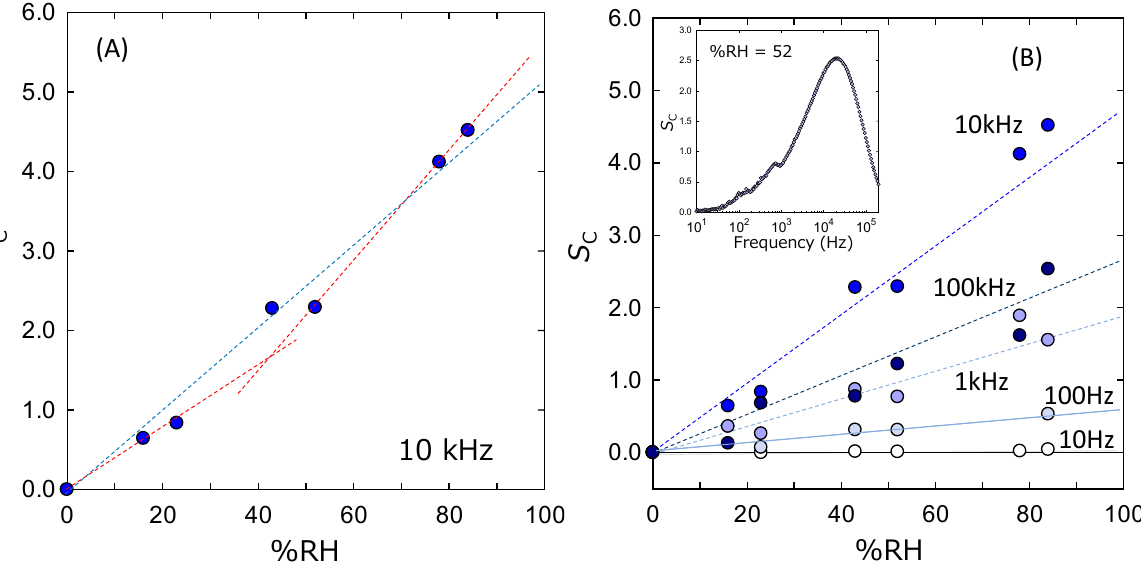
Figure 6. ( A ) Dependence of the S c on the %RH in the atmosphere of ZnAl 2 O 4 /Al device. ( B ) Dependence of relationship between the S c and %RH values on the applied AC frequency to ZnAl 2 O 4 /Al device. The inserted figure plots the S c values at %RH = 52 against the applied AC frequency.